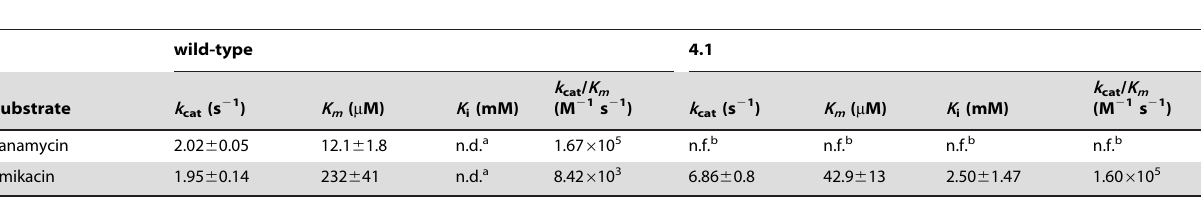
Table 4. Kinetic Parameters of the wild-type and evolved 4.1 APH(3 9 )-IIIa.